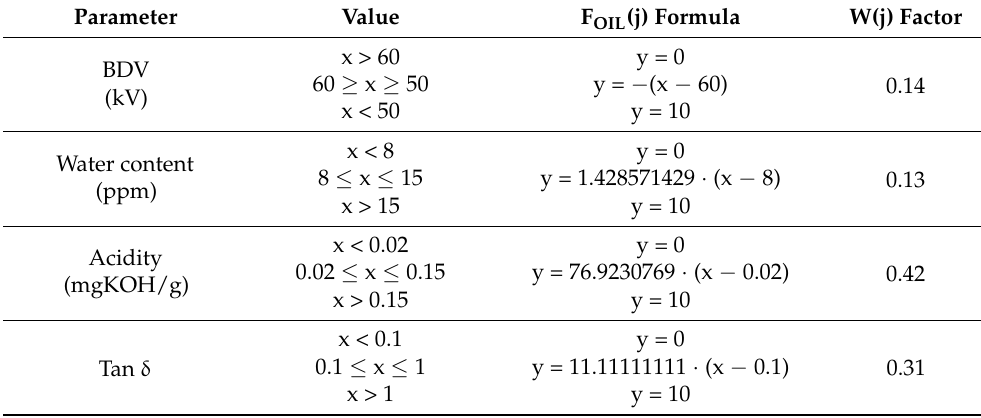
Table 4. The individual formulas and weighting factors used to evaluate the physicochemical properties of oil for transformers with the upper voltage of U > 230